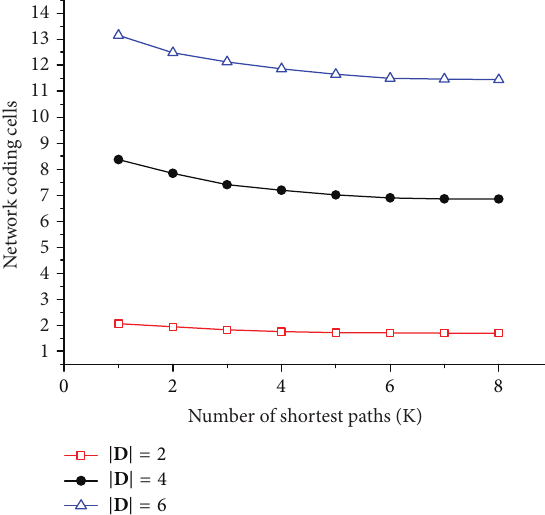
Figure 3: MR-MNCO network coding operations versus number of shortest paths (𝐾)